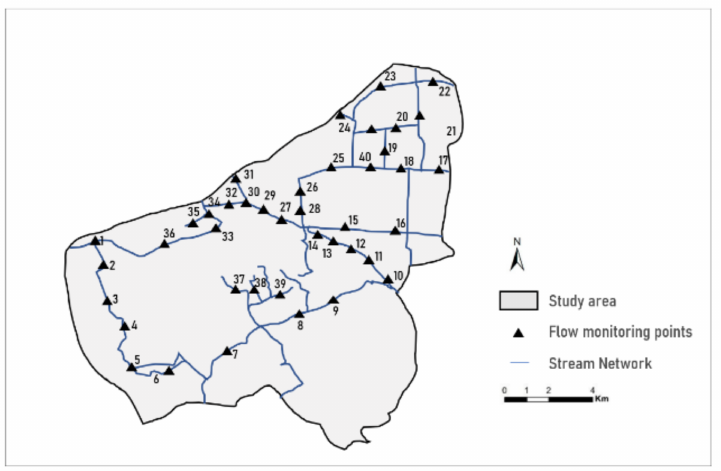
Figure 2. Spatial distribution of surface water quality monitoring